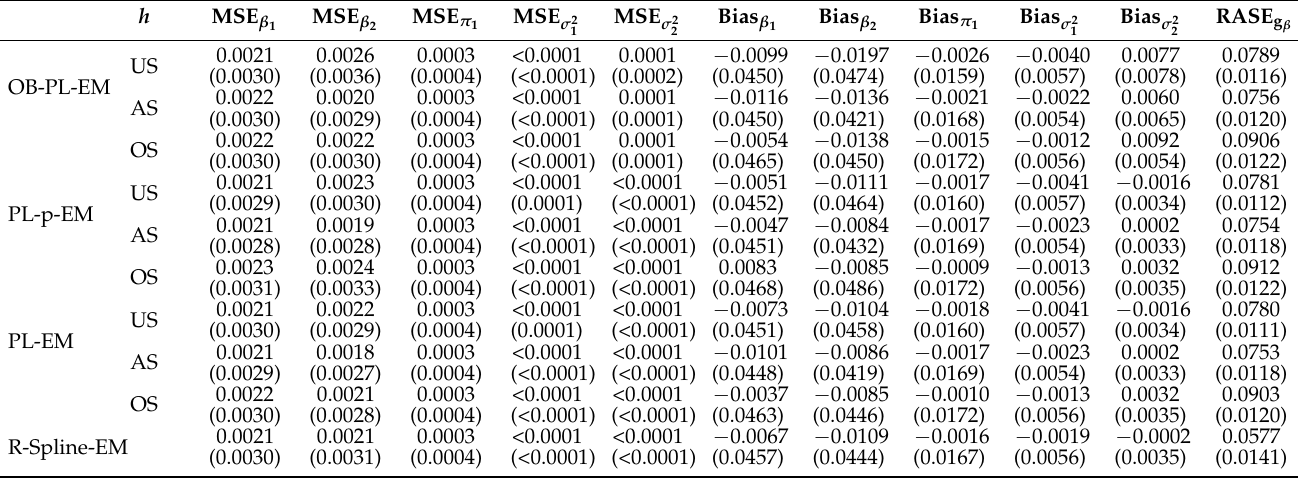
Table 4. Averages (and standard deviations) of the performance measures for n =